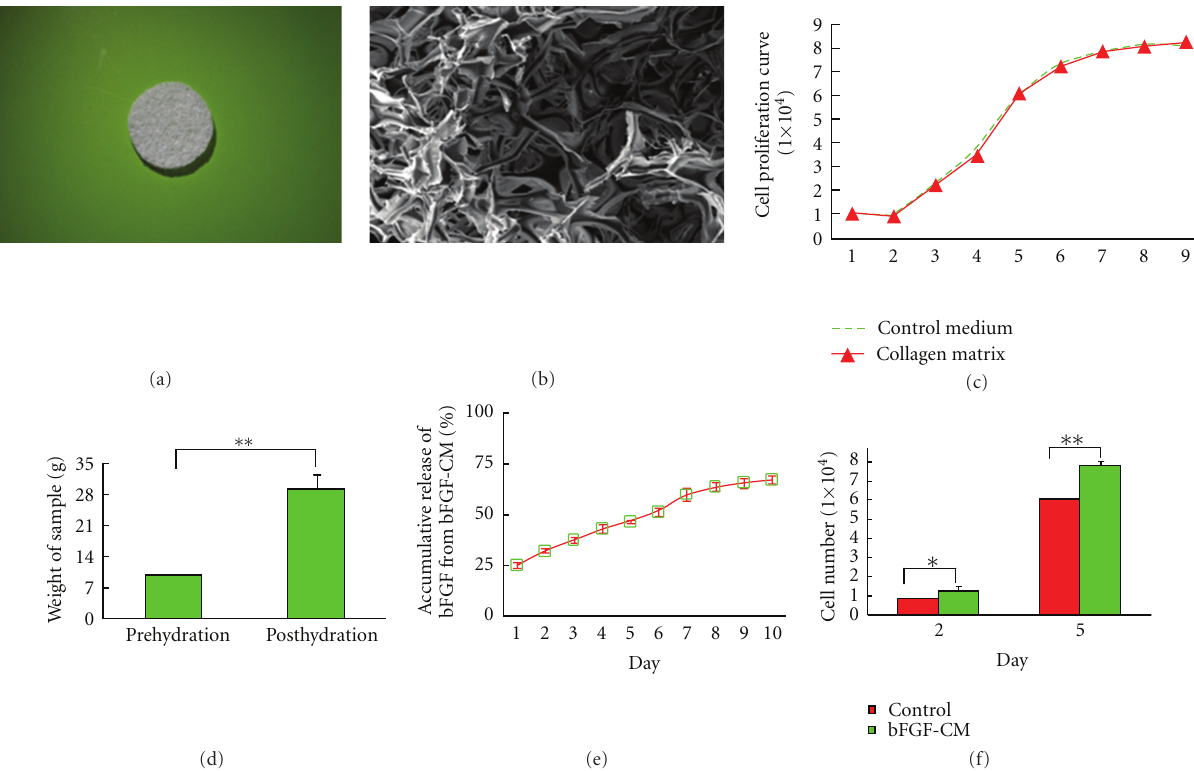
Figure 1: Characterization of the CM and the bFGF-CM complex. (a) Gross overview of the bFGF-CM complex. (b) Scanning electron microscopy indicated that bFGF-CM had a multiporous structure (bar = 100 μ m). (c) Proliferation assays showed that CM did not have a cytotoxic e ff ect on MSCs. (d) Rehydration analysis of the CM. (e) The kinetic profile of bFGF release. (f) The bioactivity analysis of the bFGF released from the bFGF-CM complex ( ∗ P < 0 . 05, ∗∗ P < 0 .